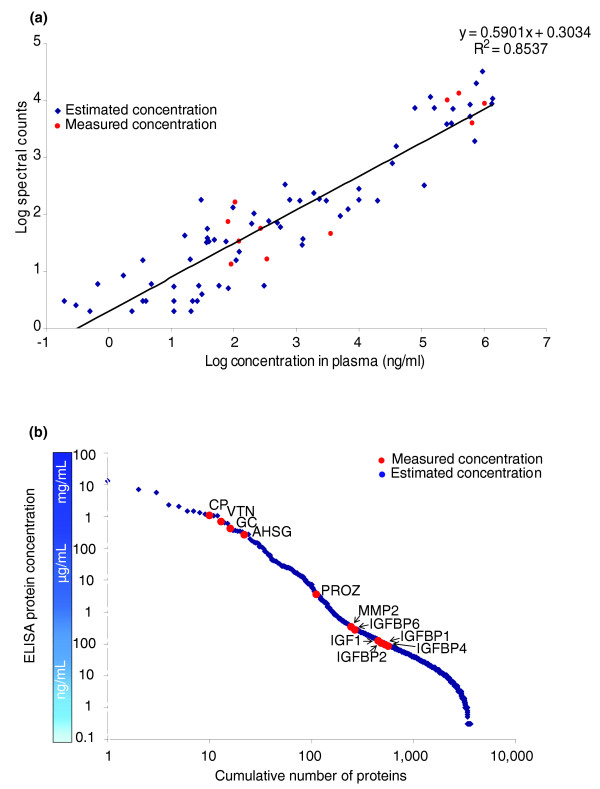
Dynamic range of IPAS MS pointing to proteins validated by ELISA. (a) Correlation between spectral counts (number of tandem mass spectra (MS2) acquired per protein) and estimated/measured serum concentrations. (b) Cumulative protein identifications are plotted versus ELISA protein concentration determined by ELISA measurments (red) and estimated concentration (blue) as determined by spectral counts.